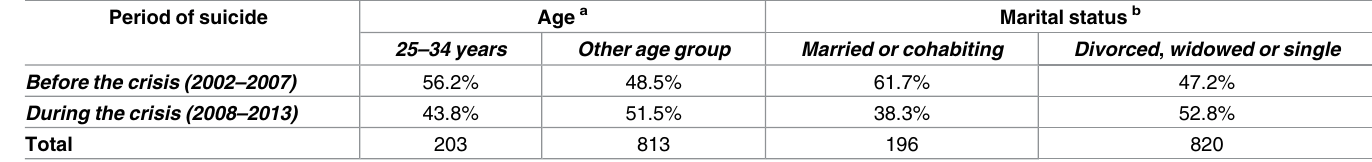
Table 3. Correlation between suicides happened before and during the economic crisis, suicide victims’ age and marital status.